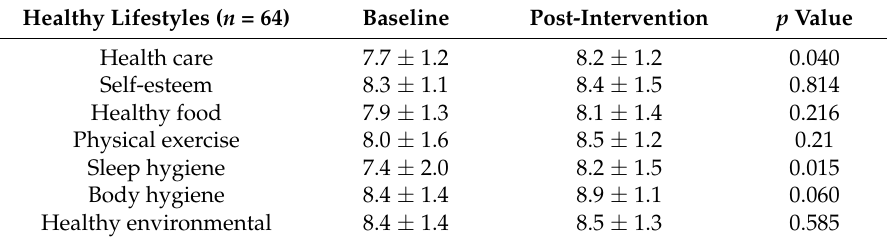
Table 6. Self-efficacy of self-care actions related to healthy lifestyles.